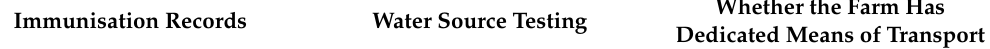
Table 6. Results of empirical analysis of factors influencing farmers’ disease prevention and control